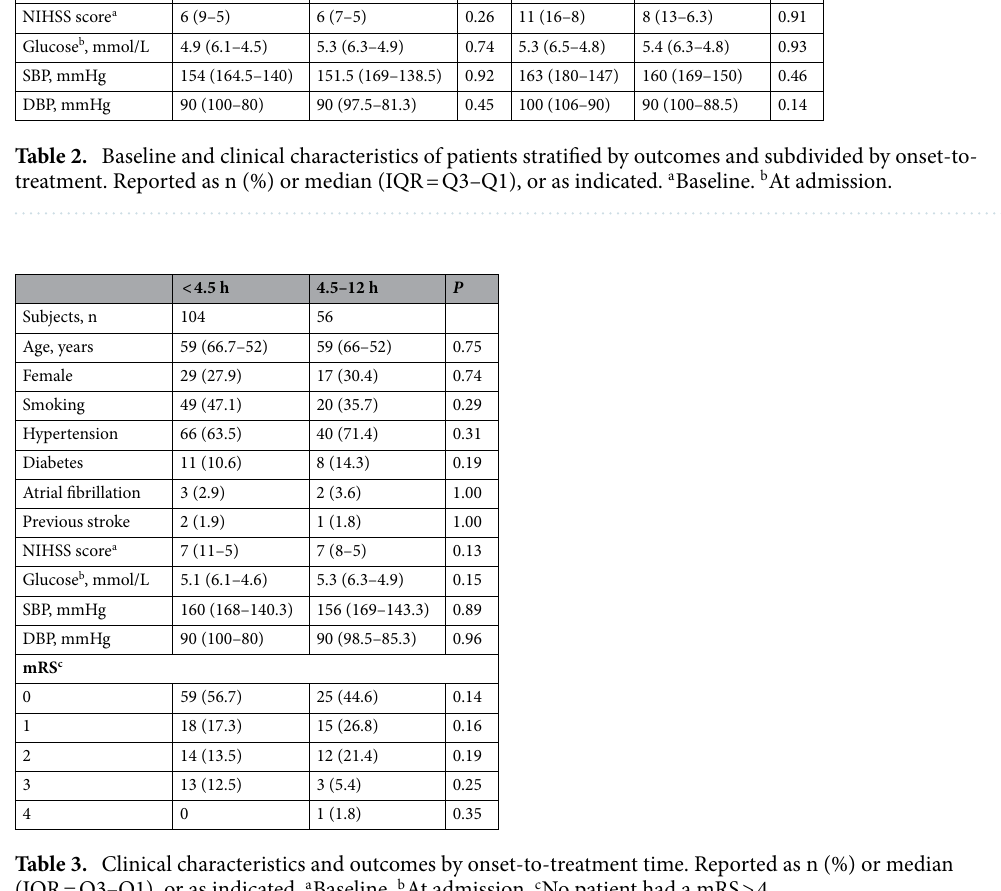
Table 3. Clinical characteristics and outcomes by onset-to-treatment time. Reported as n (%) or median (IQR = Q3–Q1), or as indicated. a Baseline. b At admission. c No patient had a mRS > 4.